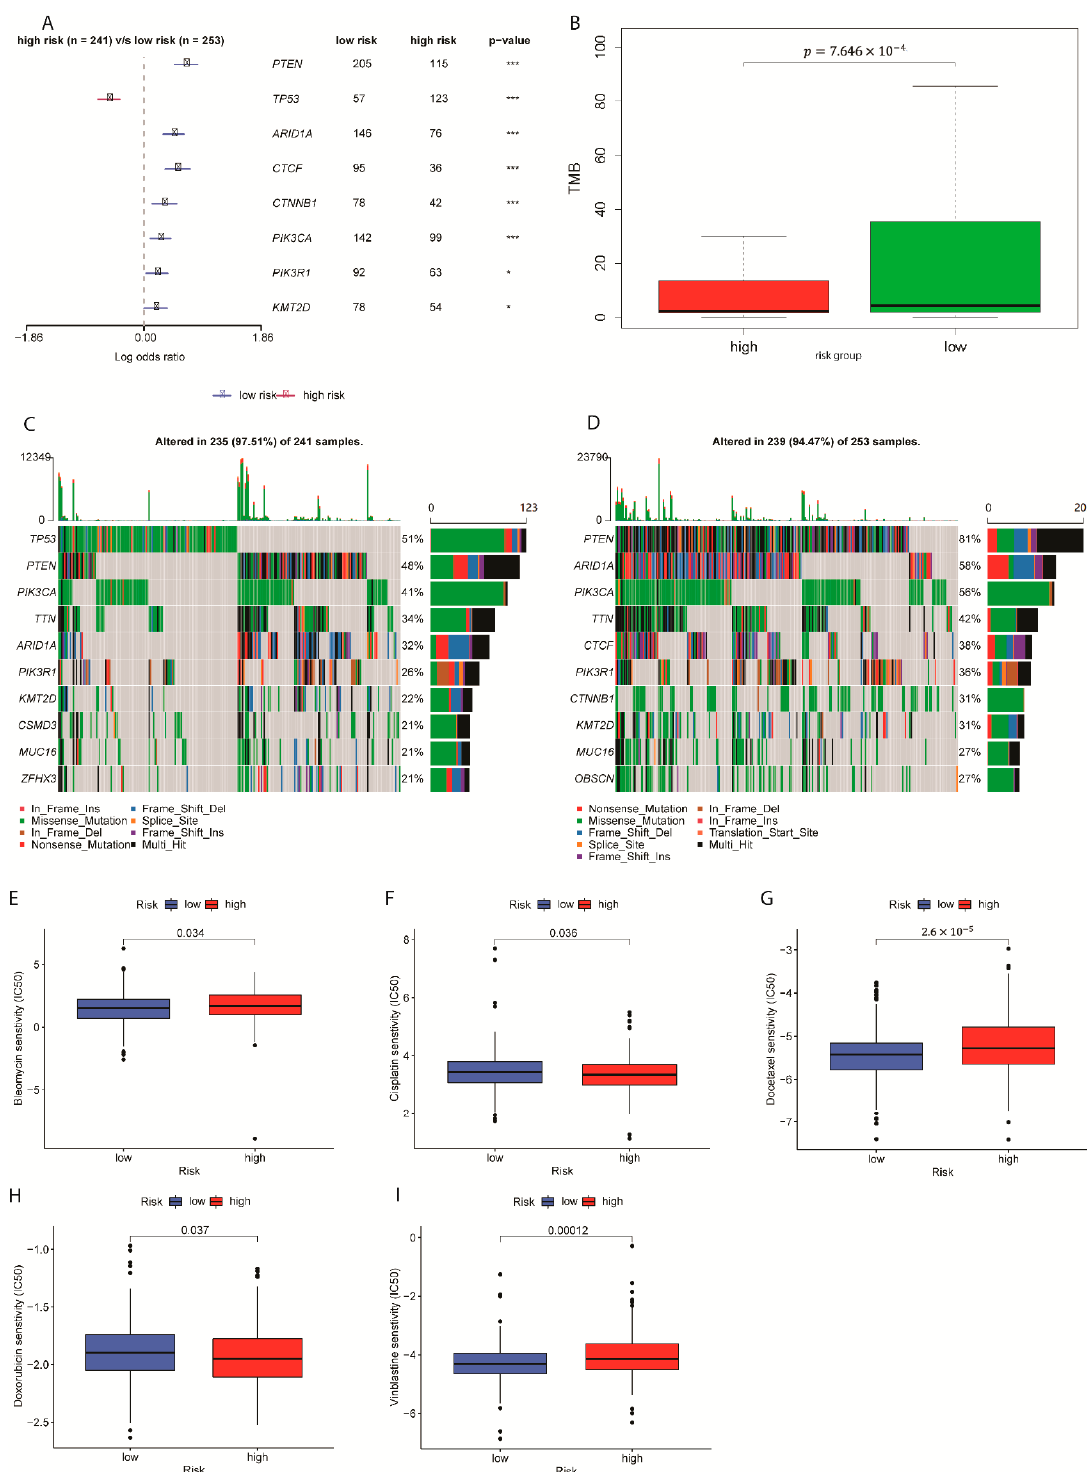
Figure 5. Gene mutation and drug sensitivity analysis in EC prognostic risk groups ( A ) Differential Expression of Top eight altered genes in risk groups. * means p < 0.05; *** means p < 0.001. ( B ) TMB for low and high-risk groups in the TCGA cohort. ( C ) Mutation profile of the high-risk group. ( D ) Mutation profile of the low-risk group. ( E – I ) Box plot of the estimated IC50 values for Bleomycin, Cisplatin, Docetaxel, Doxorubicin, and Vinblastine with two risk